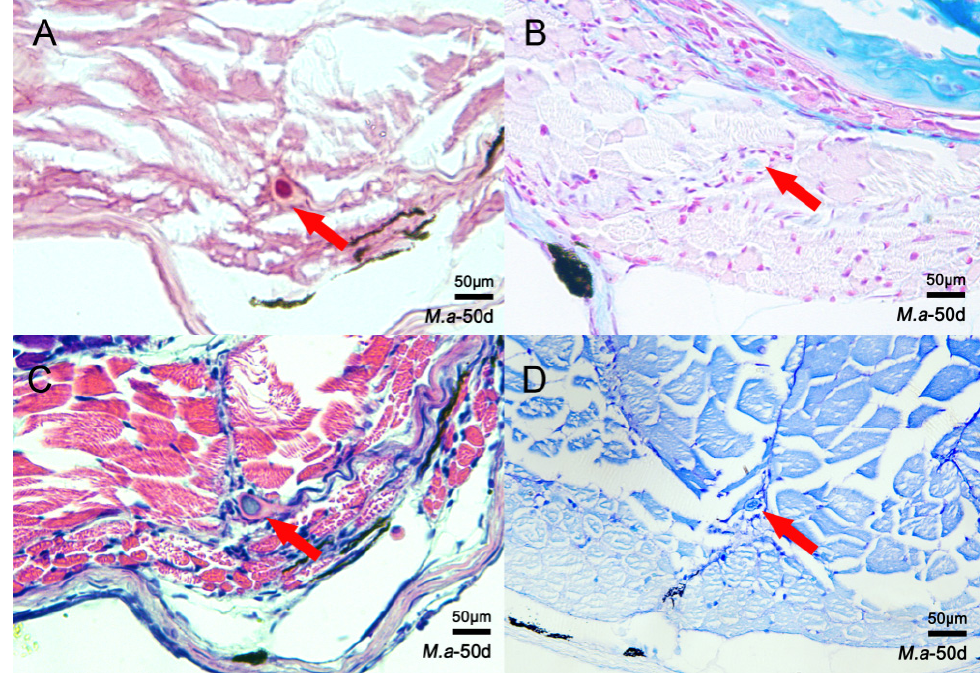
Figure 3. Histological characteristics of M. amblycephala IBs based on four staining methods at 50 dph. ( A ) Alizarin red; ( B ) alcian blue–nuclear red; ( C ) HE; ( D ) toluidine blue. The IBs are marked by red arrows.